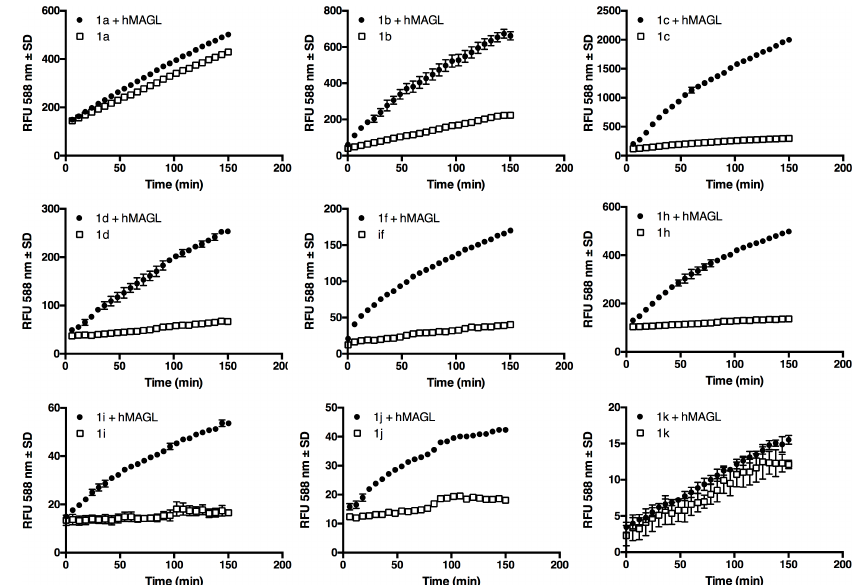
Figure 2. Time course of 1a – d , 1f , and 1h – k hydrolysis by human recombinant monoacylglycerol lipase (h MAGL). 25ng / well of h MAGL (circles) or bu ff er alone (empty squares) were incubated in 96-well black plate, at room temperature, with 5 µ M of each compound in total volume of 100 µ L / well, as described in the experimental section. Fluorescence was measured at indicated time points with a Jasco FP-8300 fluorometer (Jasco Europe, Cremella (LC) Italy) using the kinetic mode ( λ ex = 571 nm, λ em = 588 nm, slit = 5.0). Data are mean ± standard error of independent